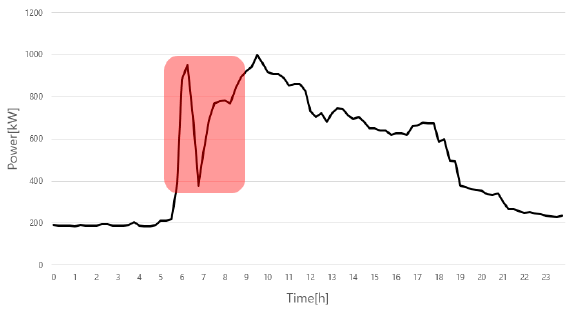
Figure 10. Special event bias.